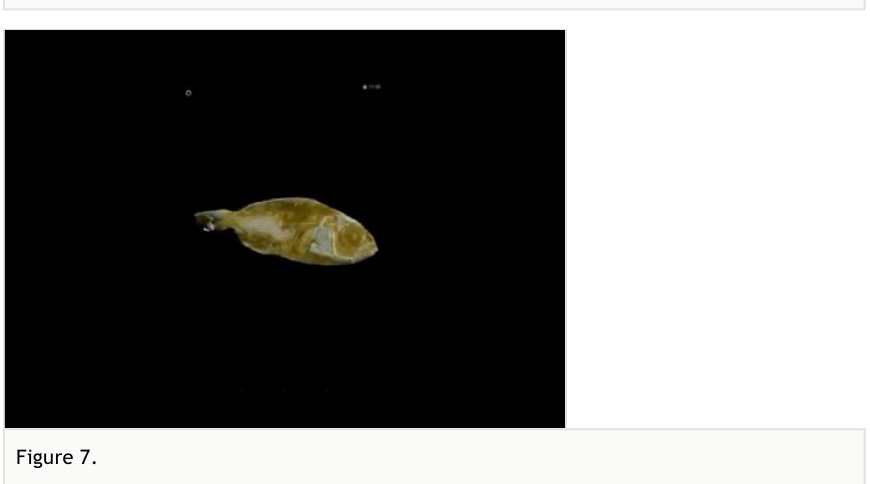
Figure 6. Schematic representation of a user interacting with the Micro-CT